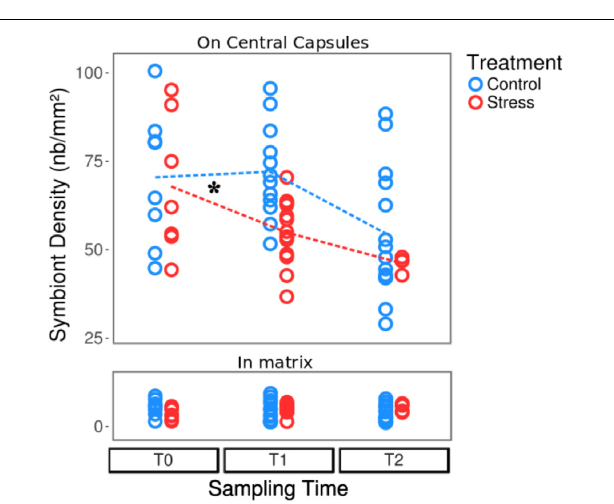
FIGURE 4 | Variations of the symbiont density in control (blue) and heat-stressed colonies (red) of Collozoum pelagicum . Control colonies were maintained at 21 ◦ C, while stressed colonies were sampled at 21 ◦ C (T0), 25 ◦ C (T1) and 28 ◦ C (T2). The upper and bottom parts represent the density of symbionts attached to central capsules and in the gelatinous matrix, respectively. As indicated by a star, slopes of reaction norms for symbionts from central capsule (represented as dotted lines) were significantly different between T0 and T1 ( p- value < 0.025), but not between T1 and T2. Statistical supports are described in Supplementary Tables 1, 4B,C